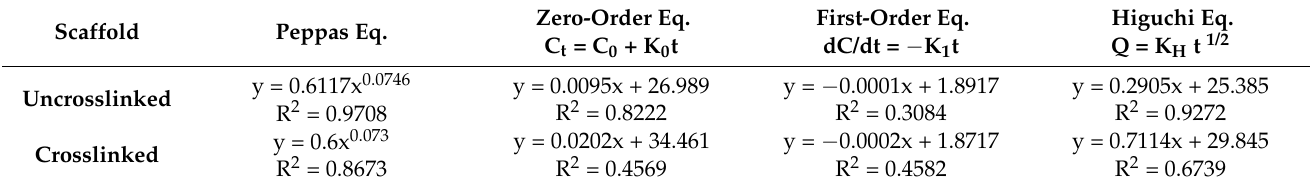
Table 3. The correlation coefficient (R 2 ) was obtained from different models fitted to the drug release